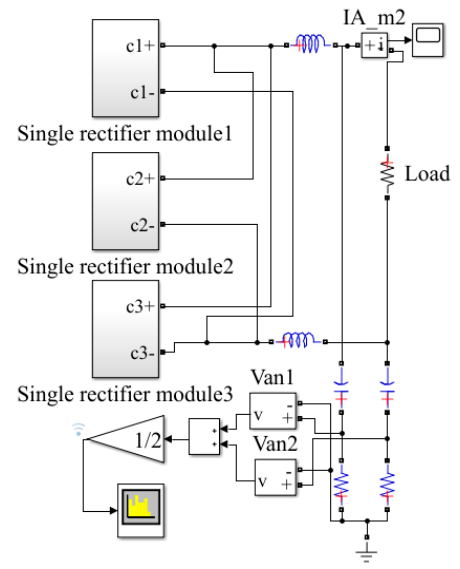
Figure 16. Three-module parallel simulation model.